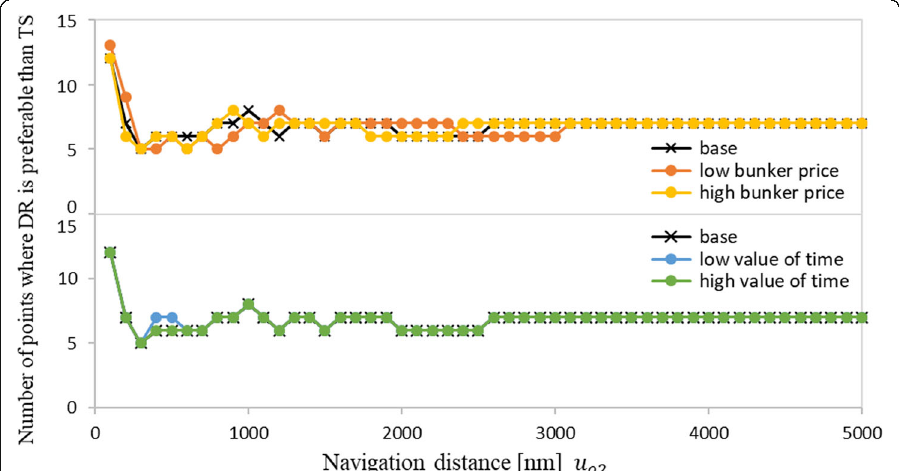
Fig. 7 Results of sensitivity